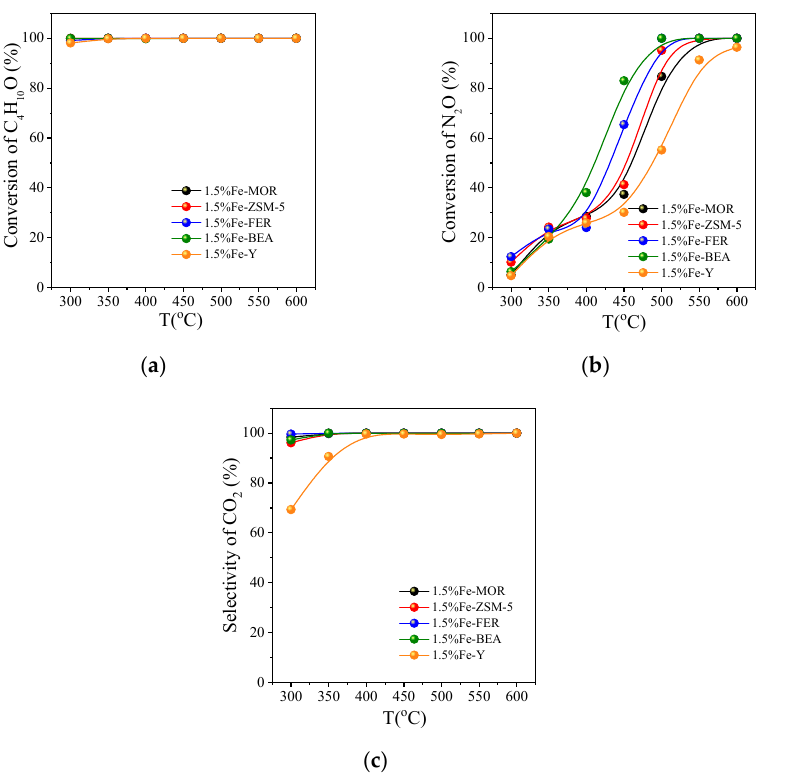
Figure 6. Catalytic oxidation of tert-butanol on zeolite catalysts loaded with 1.5% Fe: ( a ) the conversion of C 4 H 10 O; ( b ) the conversion of N 2 O; ( c ) the selectivity of CO 2 ; reaction conditions: GHSV = 8000 h − 1 , C 4 H 10 O:N 2 O:O 2 :He =